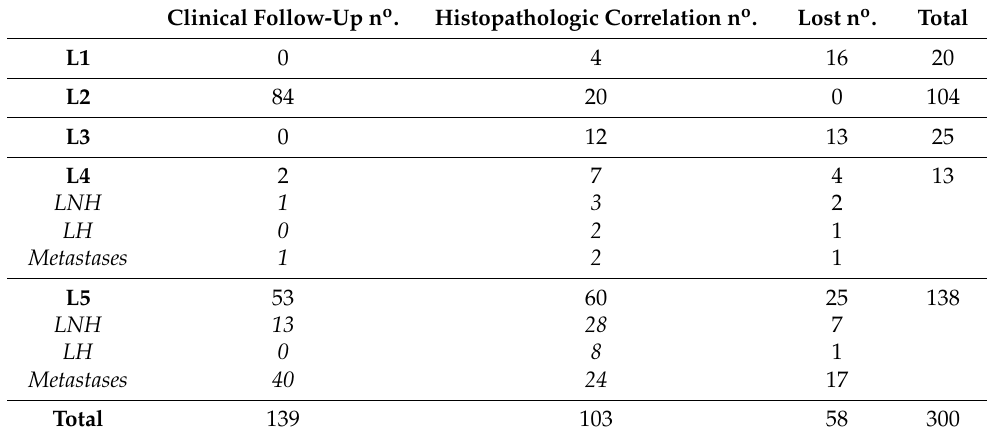
Table 3. Correlation between Sydney system diagnostic categories and histology/clinical follow-up. Clinical Follow-Up n o .